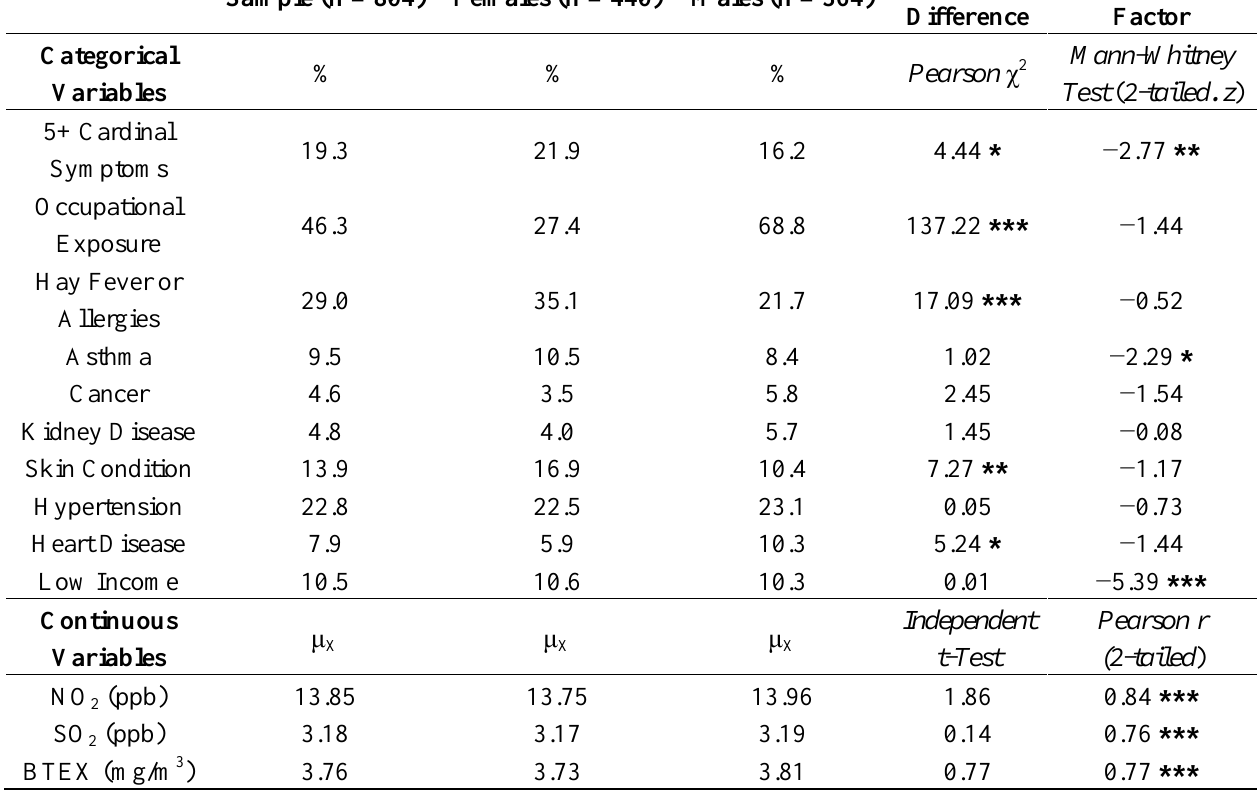
Table 1. Descriptive sample characteristics + and bivariate statistics for categorical and continuous variables in relation to sex/gender and pollution